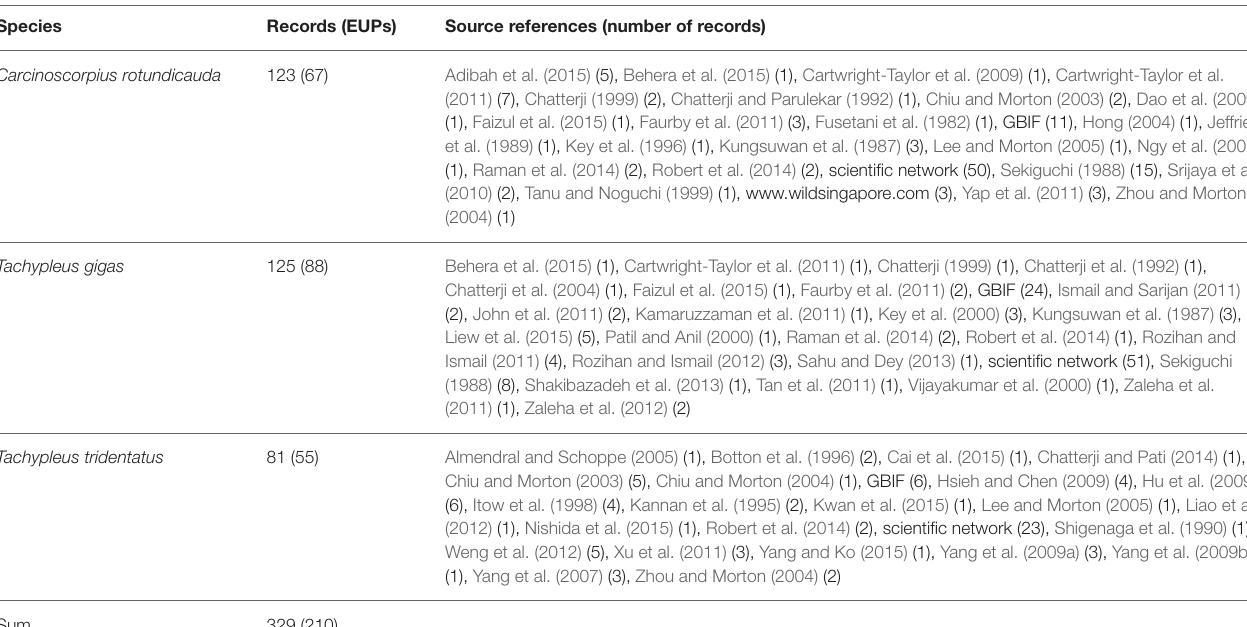
TABLE 1 | Occurrence data used in the analysis. Environmentally unique points (EUPs) were calculated from the compiled observations (records) using the respective geographical mask with a resolution of 300 arc seconds and 23 environmental variables.